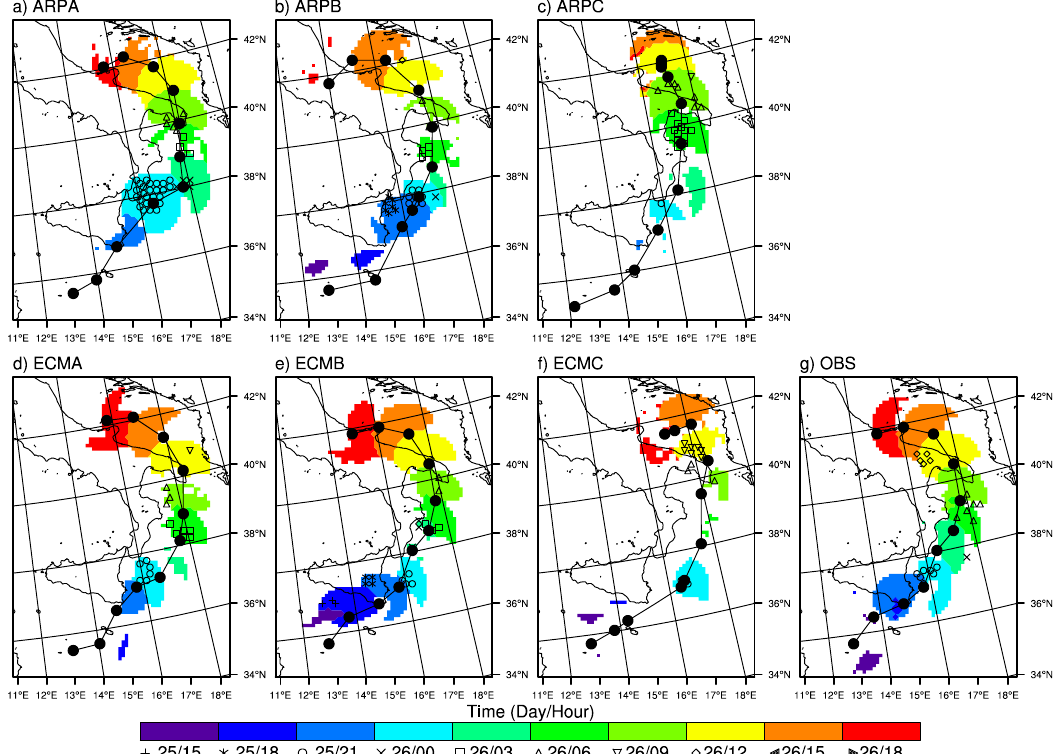
Fig. 3. Time (day/hour) associated with SEVIRI 10.8µm BT less than 250K (shading) and AMSU-B DCT (symbols) from 15:00UTC, 25 September to 18:00UTC, 26 September 2006 within an 80-km circle centred on the medicane for (a–f) Meso-NH forecasts and (g) MSG and AMSU-B observations. The positions and track of the medicane are shown at 3h intervals with filled dots and lines, respectively.